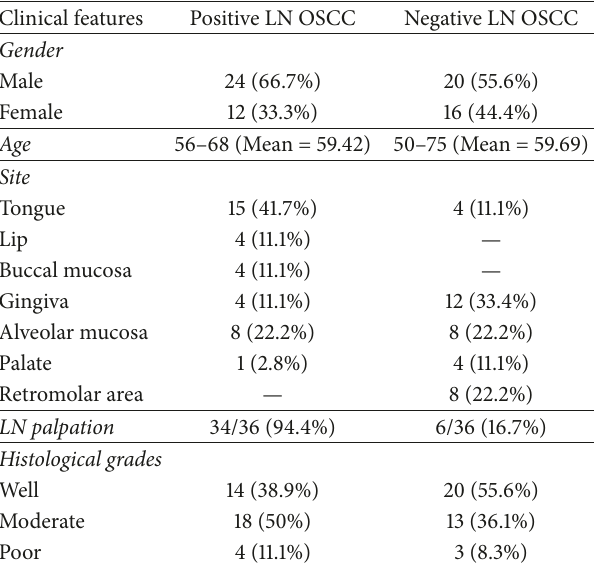
Table 1: Clinical data and histological grades of the studied